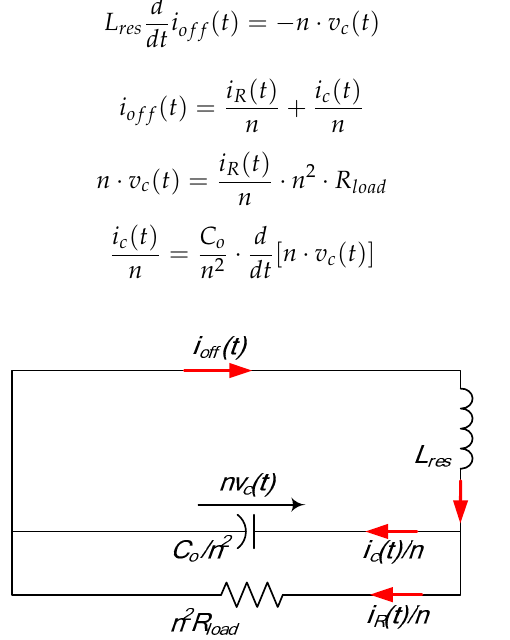
Figure 5. Load Current for ZCS and ZVS: ( a ) ZCS; ( b ) Marginal ZCS; ( c ) Neither ZCS nor ZVS; ( d ) Marginal ZVS.